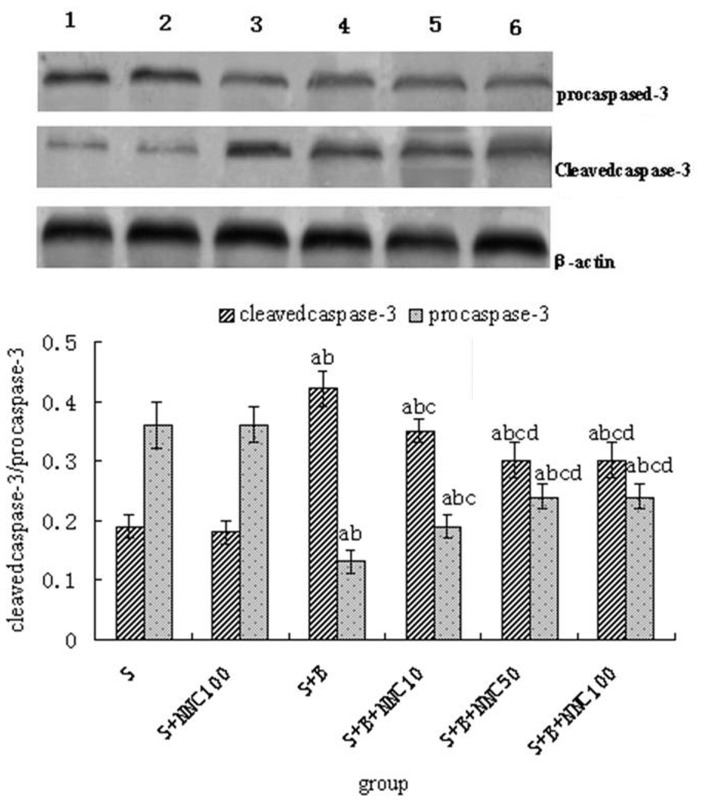
Inhibition of T-type calcium channels prevents bupivacaine-induced cleavage of caspase-3.SH-SY5Y cells were either pretreated with the indicated concentrations of NNC 55-0396 dihydrochloride or left untreated prior to 1 mM bupivaine exposure for 24 h. Procaspase-3 (inactive form) and cleaved caspase-3 (active form) expression was measured by western blot analysis (mean+S.D, n = 6). Lane 1 = S group; Lane 2 = S+NNC 100 group; Lane 3 = S+B group; Lane 4 = S+B+ NNC 10 group; Lane 5 = S+B+NNC 50 group; Lane 6 = S+B+NNC 100 group. aP<0.05 vs. S group; bP<0.05 vs. S+NNC 100 group; cP<0.05 vs. S+B group; dP<0.05 vs. S+B+NNC 10 group.